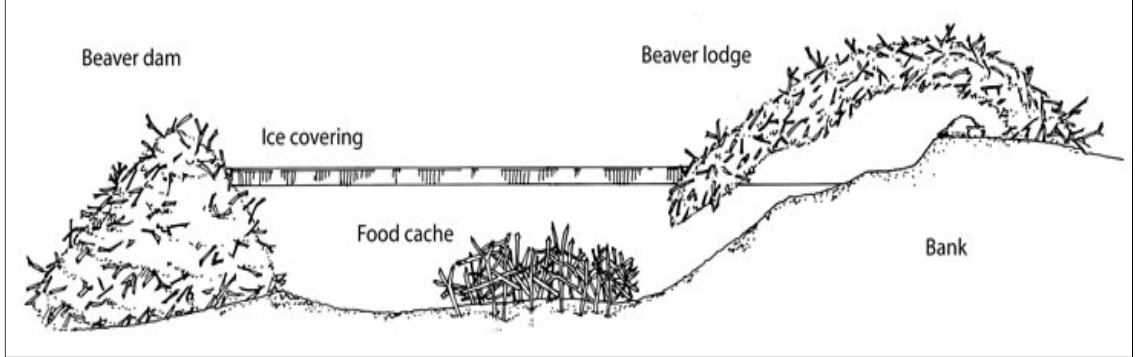
Figure 6. Diagram of beaver’s dam and lodge (Source: https://www.hww.ca/en/wildlife/mam- mals/beaver.html).